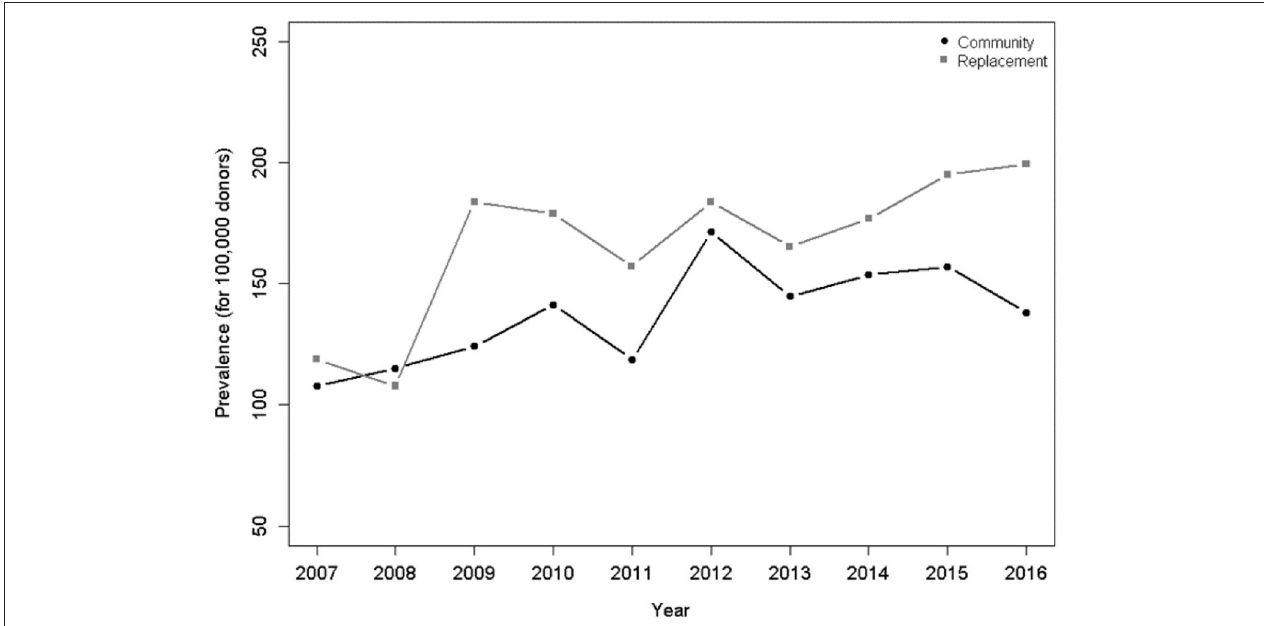
FIGURE 7 | Prevalence per 100,000 donors per year and type of donor. There was a significant upward trend for both groups, including community donors ( p = 0.025) and donors of replacement ( p < 0.001) in the Poisson